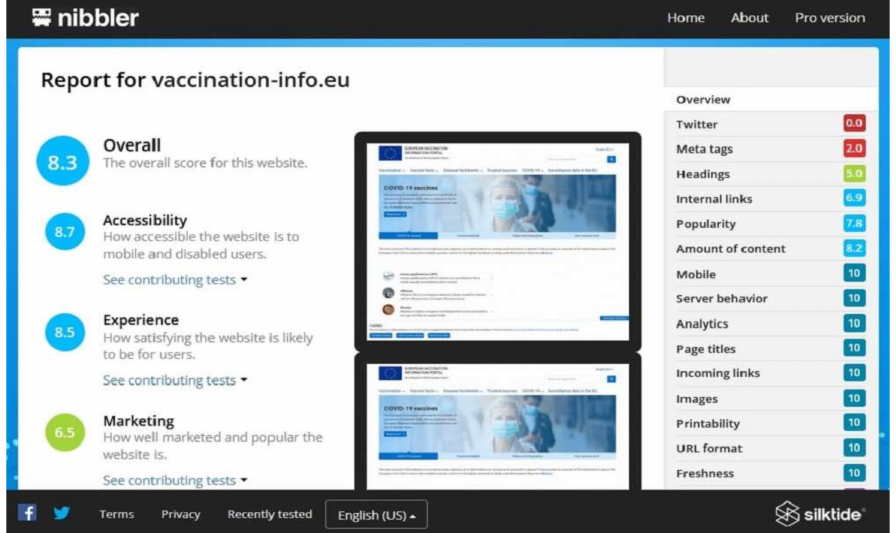
Figure 5. Screenshot of Nibbler web accessibility testing tool.